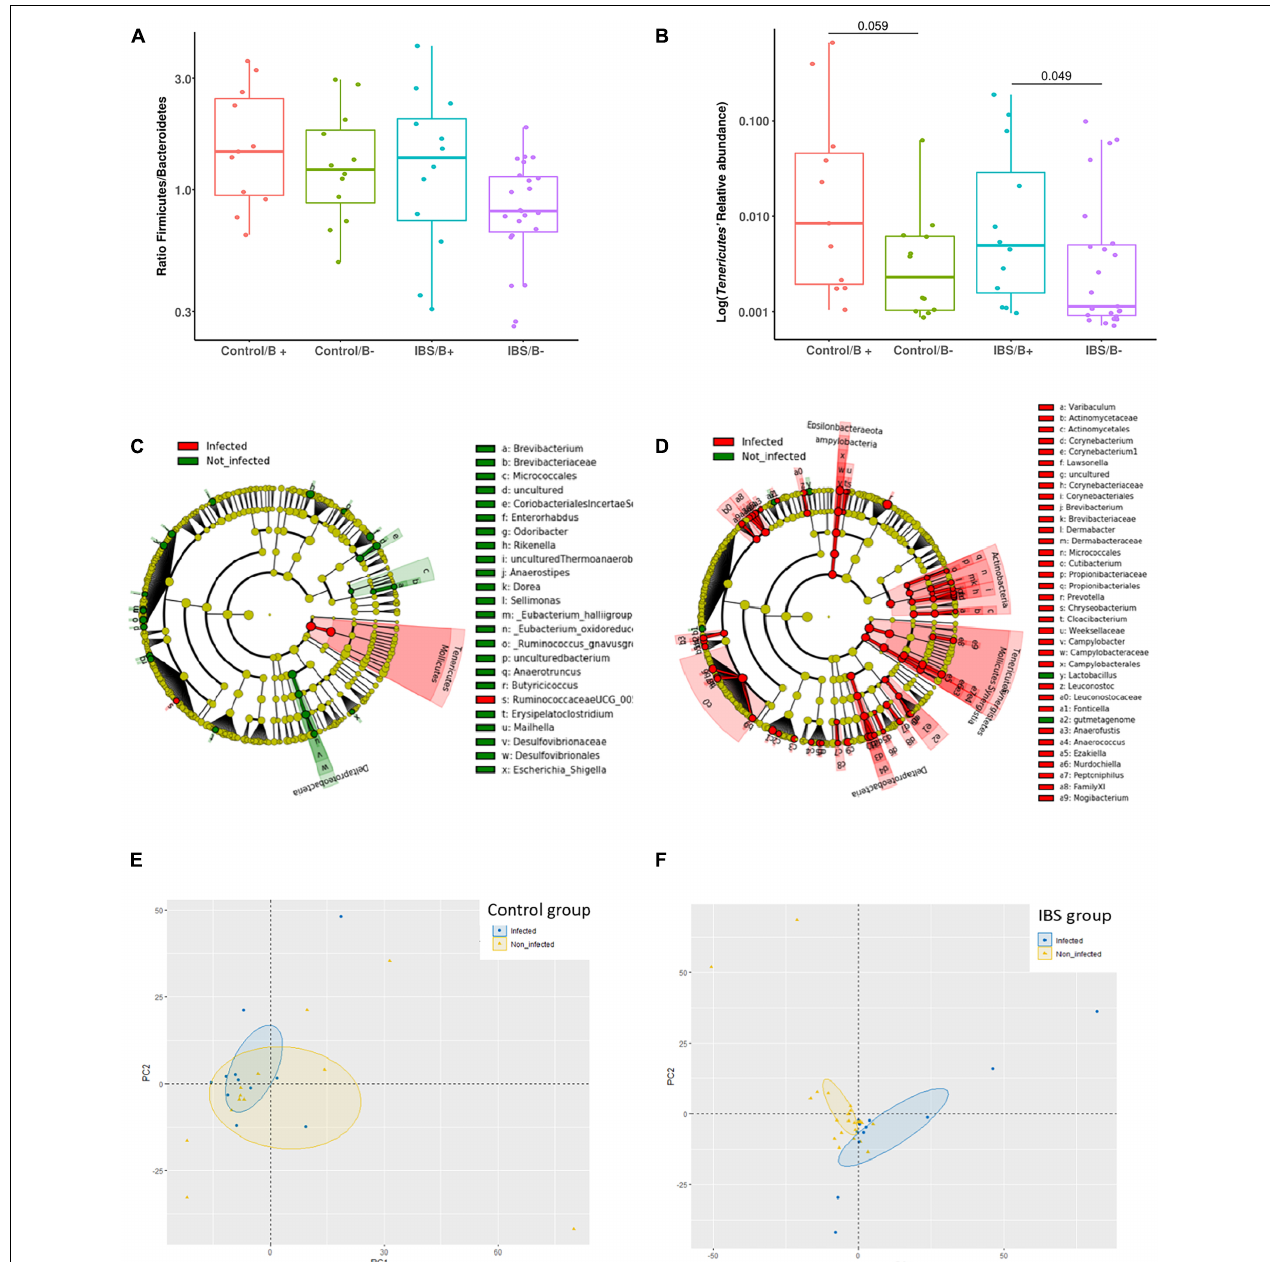
FIGURE 3 | Investigations about bacterial phyla/members that drive differences in each group of patients according to Blastocystis carriage. (A,B) Analysis at the phyla level: (A) Firmicutes/Bacteroidetes ratio in controls and IBS according to Blastocystis carriage. (B) Relative abundance of Tenericutes . Statistical significance was determined by Mann–Whitney test. Significant (or close to significance) p -values were reported on boxplots. IBS/B-: Blastocystis -negative IBS patients; IBS/B + : Blastocystis -positive IBS patients; Control/B-: Blastocystis -negative control subjects; Control/B + : Blastocystis -positive control subjects. (C,D) LefSe (LDA Effect Size) analysis in the control group (C) and the IBS group (D) . Red, taxa higher in Blastocystis -infected subjects; green, taxa higher in non- Blastocystis -infected subjects. Statistical significance was determined by LefSe analysis with FDR correction (only those species with q values < 0.05 and LDA effect size > 2 are shown). (E,F) Beta diversity analysis: PCoA of the unweighted UniFrac distance of non-carriers (yellow plots) and carriers (blue plots) of Blastocystis in the control group (E) and the IBS group (B) .